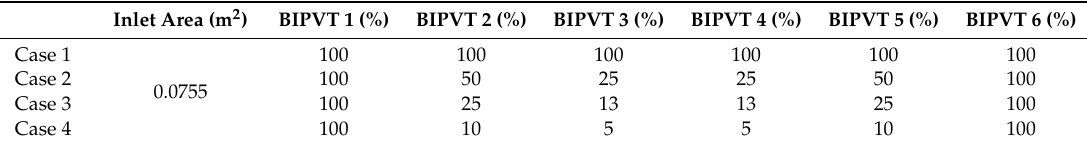
Table 1. Inlet open rate of air-type BIPVT collector.